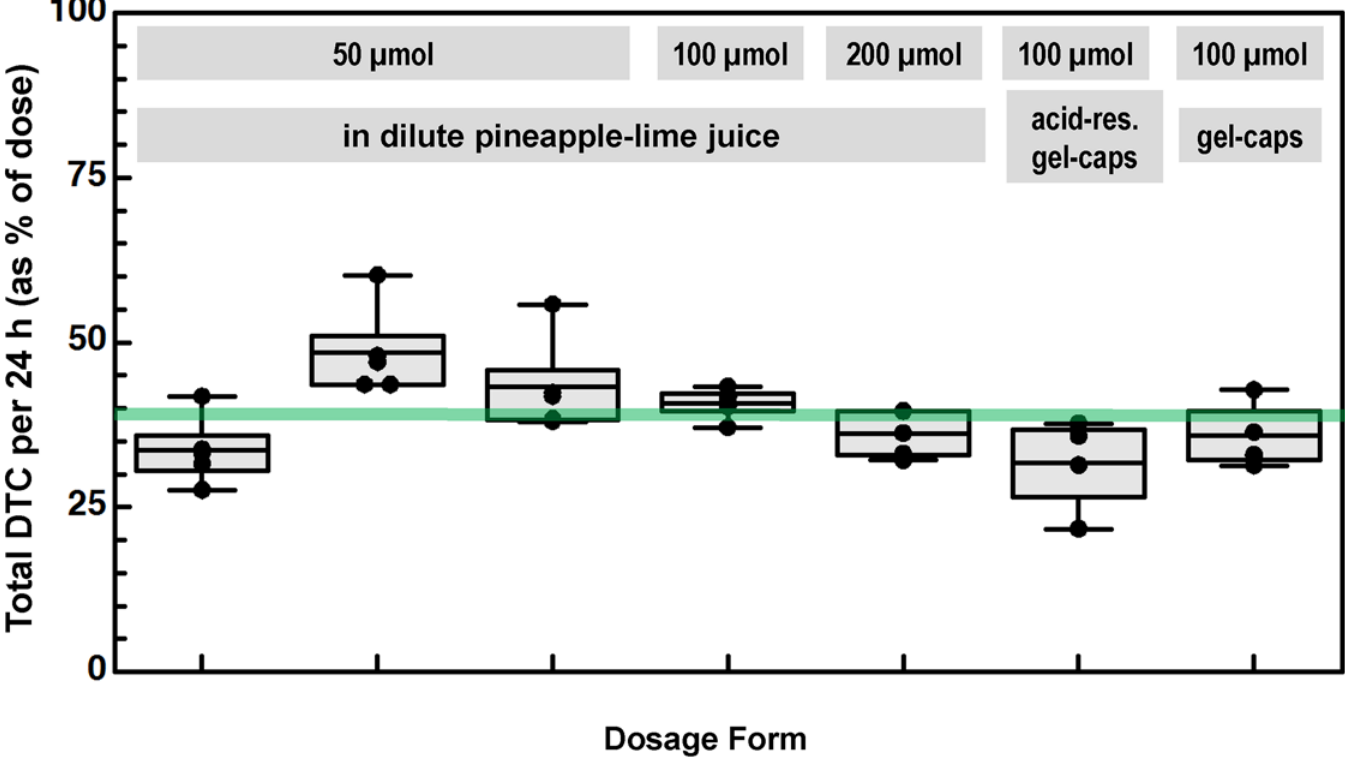
Fig 3. Mean daily excretion / conversion of freeze-dried broccoli sprouts (FDBS) containing active myrosinase, to SF metabolites. (see also Table 1, Cohort 4). Preparations were either pre-mixed in dilute pineapple-lime juice for 15 min at room temperature to allow autolysis in-vitro, and then consumed directly by volunteers (40.5% conversion), or swallowed in either acid-resistant or standard gel-caps (33.8% conversion). The same 5 subjects performed each test. There was no effect of subject on conversion (p = 0.2740) by repeated measures analysis of variance. There was a significant difference (by oneway anova with Bonferroni adjustment and Bartlett ’ s test for equal variances), between replicates at the 50 μ mol dose level (p = 0.0107), but no significant difference between dose levels (pooled replicates; p = 0.3329) or dose matrices (p = 0.3735 between capsule types and p = 0.0255 between capsules and